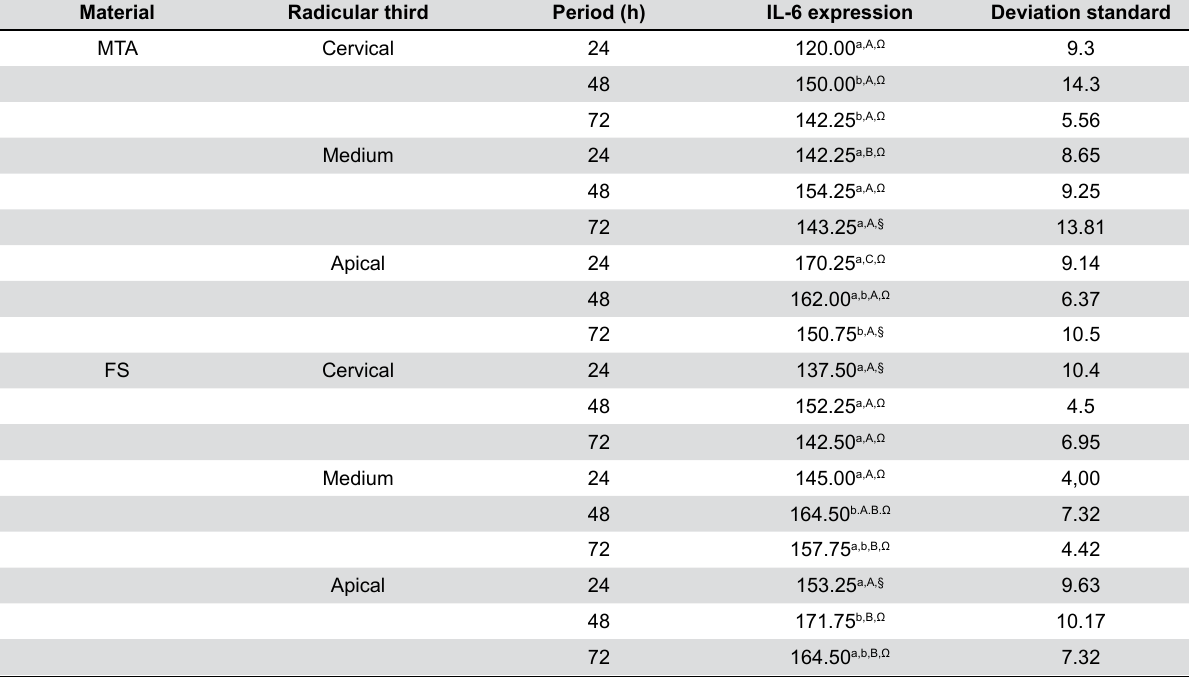
*Results of Tukey test. Means followed by different lowercase letters indicate statistical differences between the periods of evaluation for the same radicular third of teeth treated with MTA or FS (p<0.05).**Means followed by different capital letters indicate statistical differences between the radicular thirds for the same period of evaluation of teeth treated with MTA or FS (p<0.05). ***Different symbols indicate statistical differences between MTA and FS, for the same radicular third and period of evaluation (p<0.05)